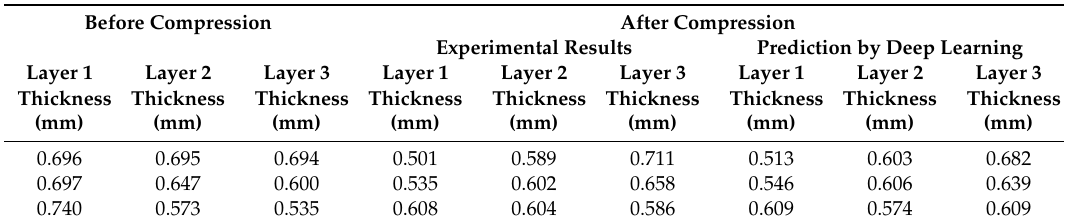
Table 4. Experimentally obtained thickness [22] for three-layer compression and deep learning prediction based on training using both two-layer compression data (Table 1) and three-layer compression data (Table